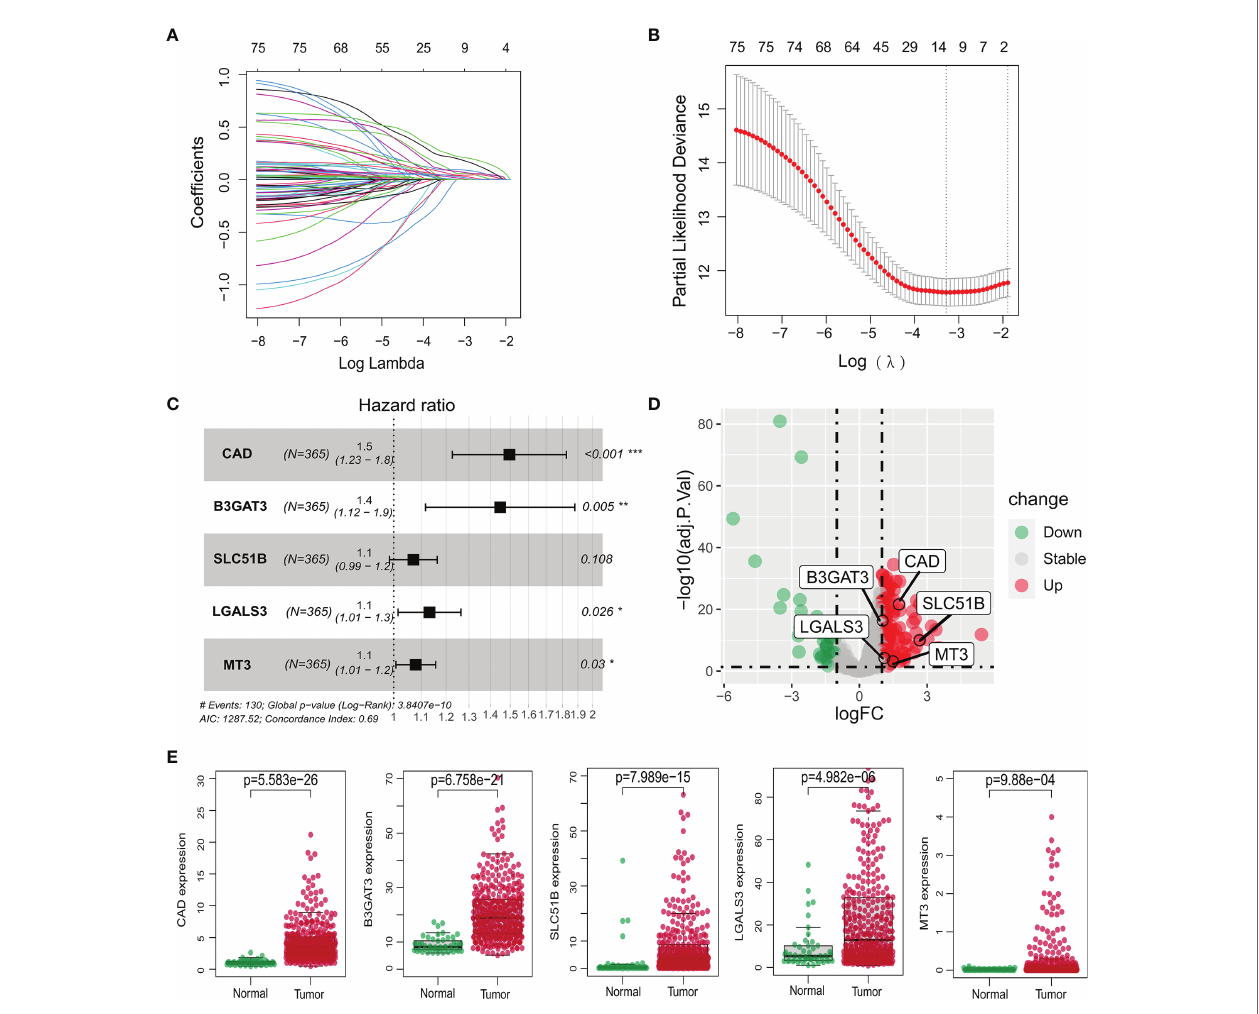
FIGURE 2 | Construction of the prognostic model of the TCGA-LIHC cohort. (A, B) Lasso regression analysis of survival-associated genes. (C) Multivariate Cox regression con fi rming fi ve glycosylation-related genes. (D) Volcano plot of differentially expressed genes between HCC and non-tumor tissues. The fi ve genes are marked. Red: signi fi cant upregulation; blue: signi fi cant downregulation; grey: no statistical signi fi cance. (E) Expression levels of fi ve glycosylation-related genes between normal and HCC samples. * P < 0.05; ** P < 0.01; *** P < 0.001.